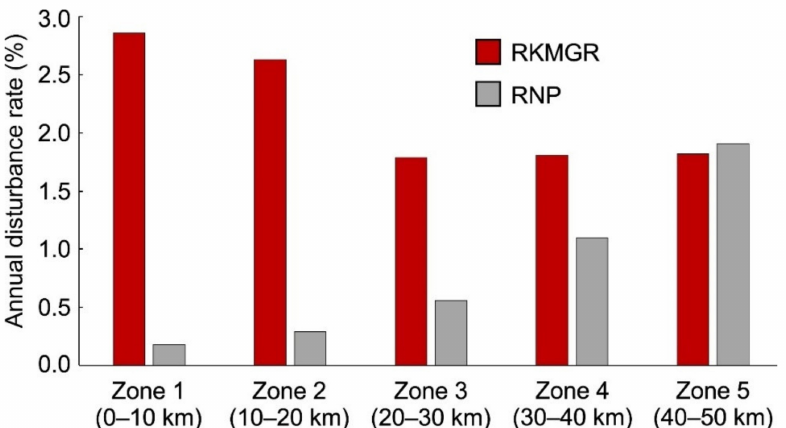
Figure 7. Annual disturbance rate for each zone surrounding the RKMGR and